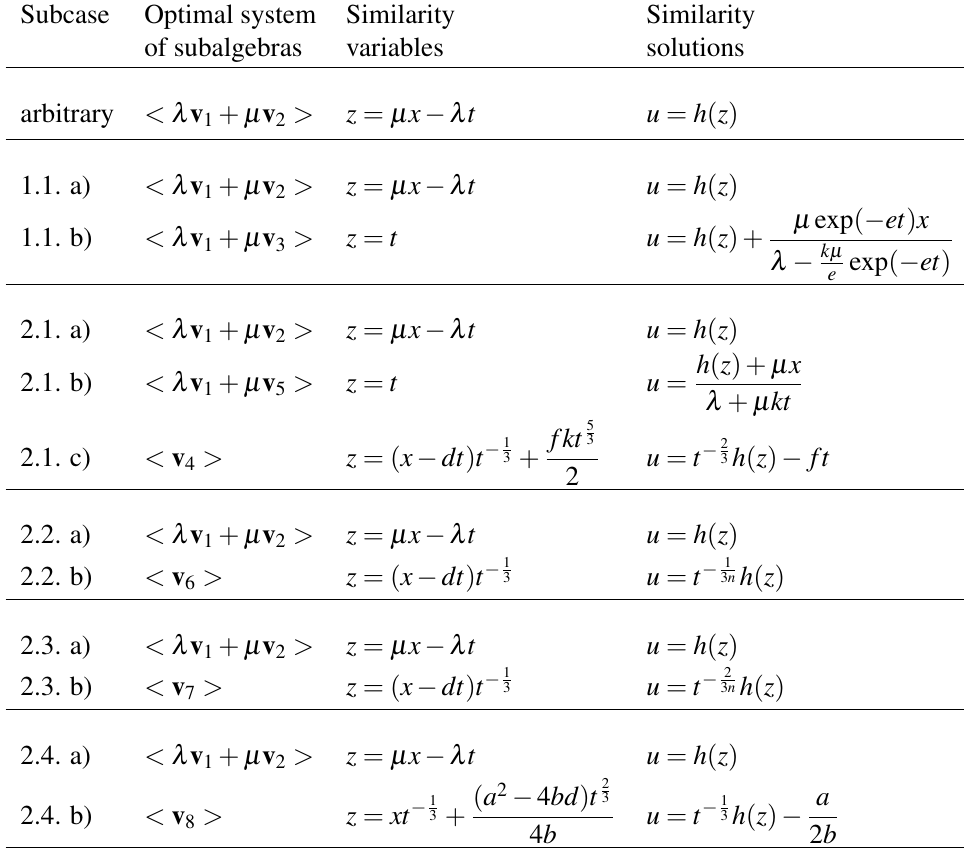
Table 1 Similarity solutions and similarity variables of equation (1) Subcase Optimal system Similarity Similarity of subalgebras variables